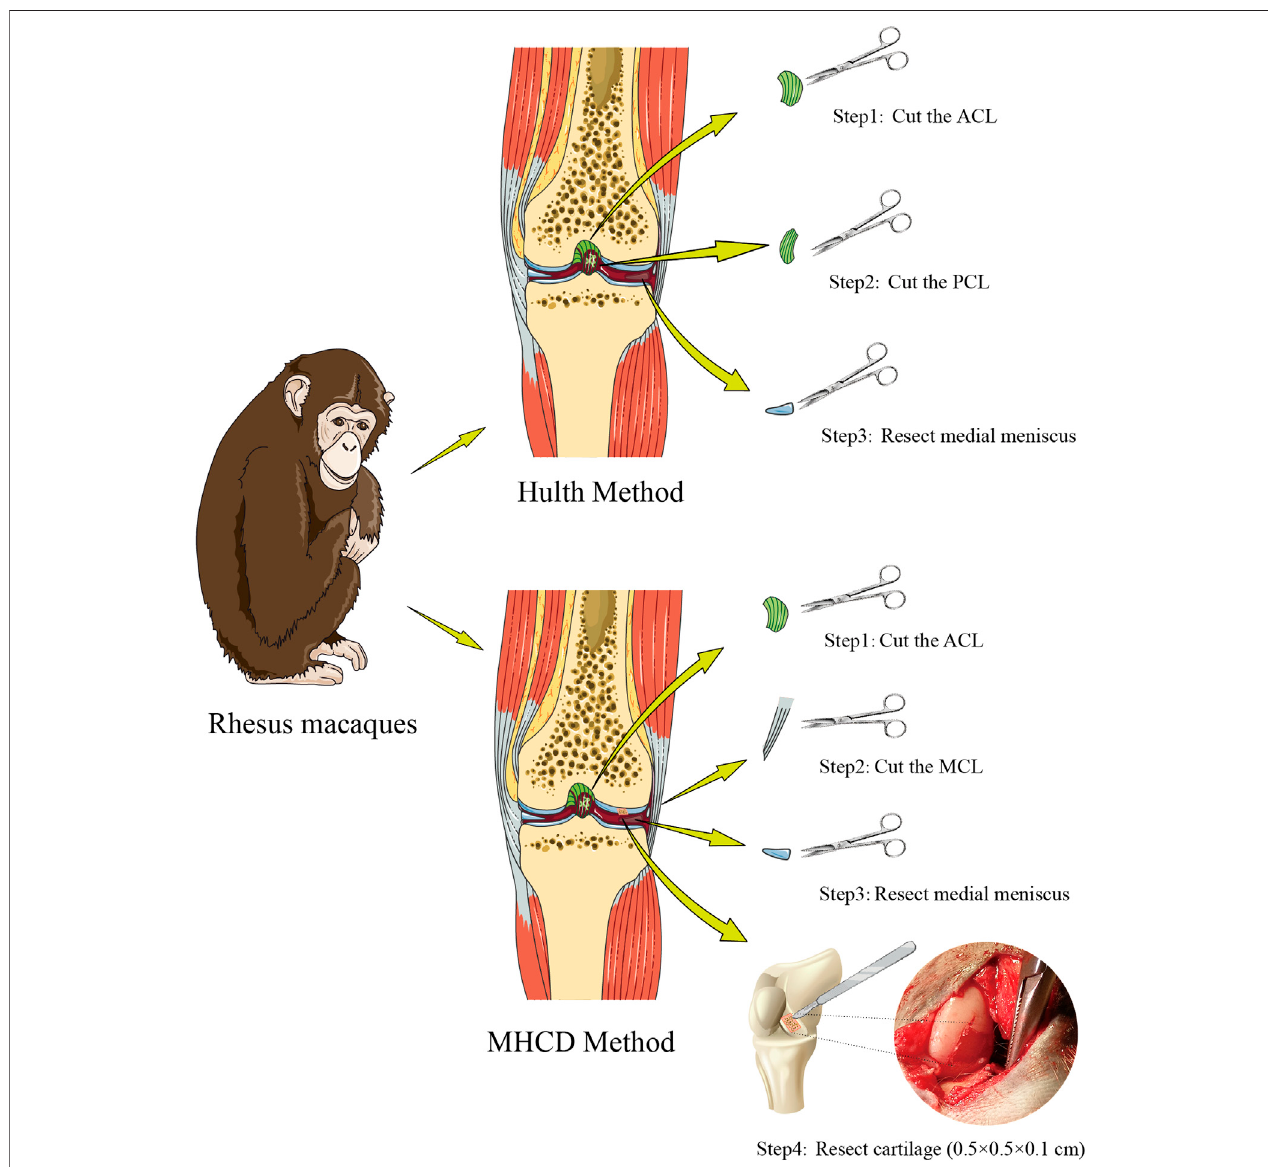
FIGURE 1 | Scheme showing the processes of modeling knee osteoarthritis in rhesus macaques using the Hulth and MHCD methods. Abbreviations: MHCD, modi fi ed Hulth combined with cartilage defect; ACL, anterior cruciate ligament; PCL, posterior cruciate ligament; MCL, medial collateral ligament.